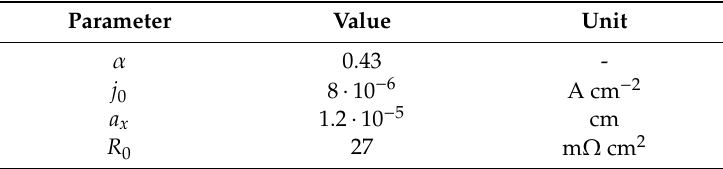
Table 2. Parameter values evaluated for this